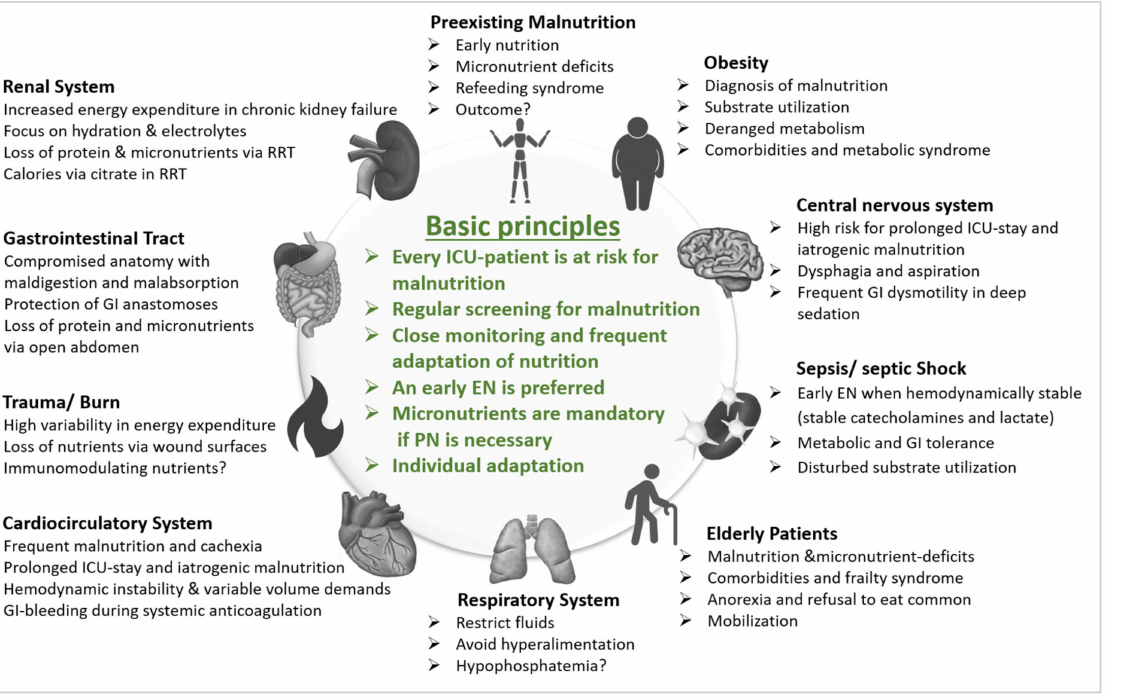
Figure 1. Overview important aspects of medical nutrition therapy in different patient groups. Abbreviations: EN: enteral nutrition, GI: gastrointestinal, PN: parenteral nutrition, RRT: renal replacement